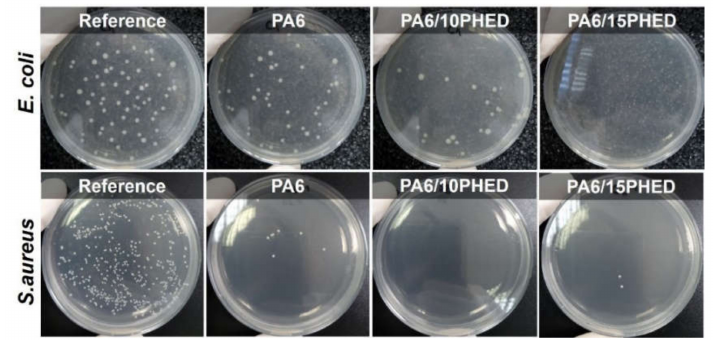
Figure 3. The grown E. coli and S. aureus bacteria on the agar plates after incubation, obtained for the reference inoculum and inoculums that were in contact with the PA6, PA6/10PHED, and PA6/15PHED fiber